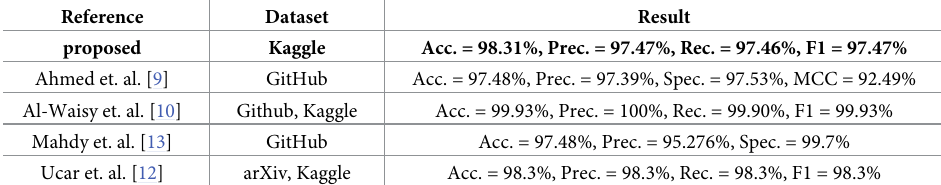
Table 3. Comparison between the proposed method and SOTA